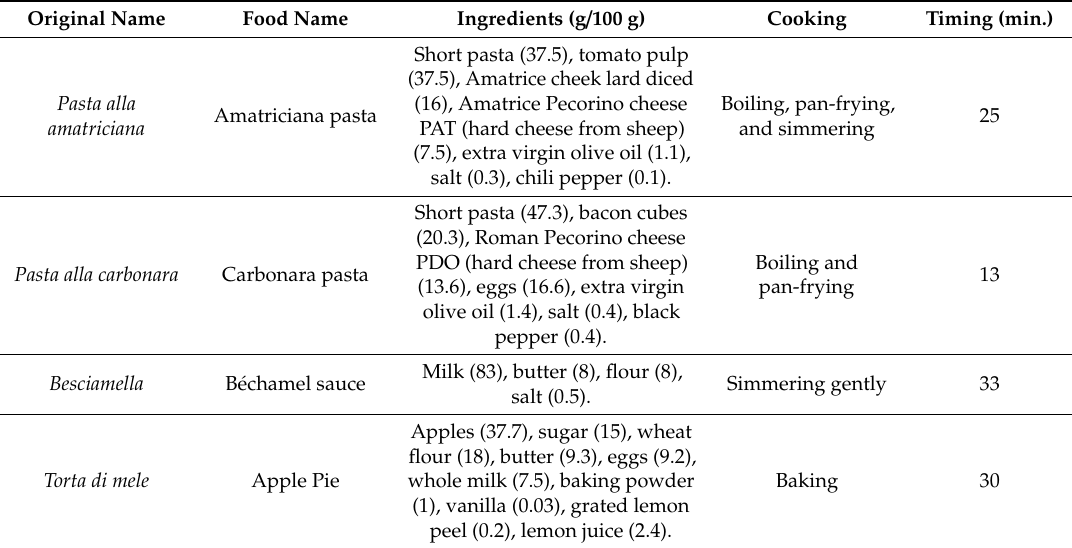
Table 3. Italian popular dishes: ingredients, method and time